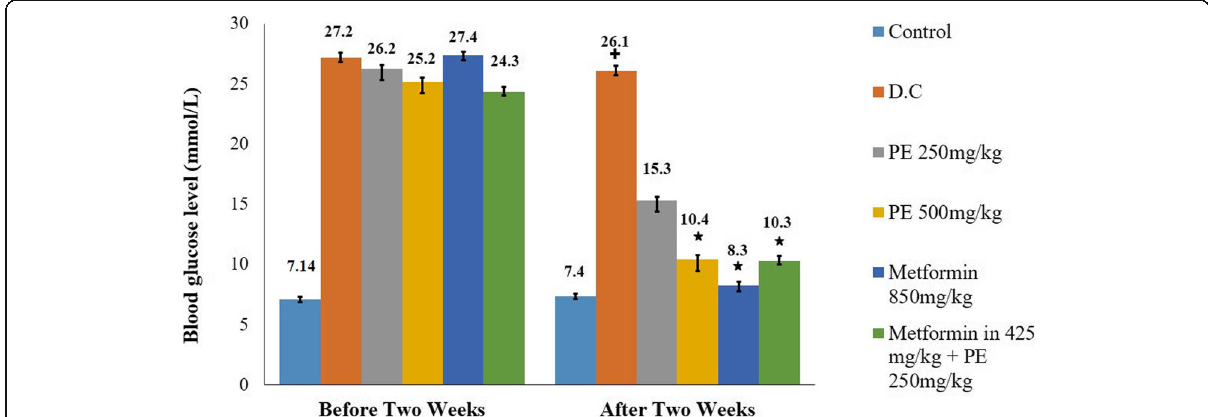
Fig. 1 Effect of the oral administration of N. cadamba flower extract on the blood glucose level in normal and diabetic rat. Effect of the oral administration of N. cadamba flower extract (given separately at two different doses or in combination with the standard metformin) on the blood glucose level in normal and diabetic rat. Here, DC = Diabetic control, PE = Plant extract. All the values are expressed as mean ± SEM, sample size ( n = 5), (*) indicates p < 0.05 compared to diabetic control group,(+) indicates p < 0.05 compared to normal